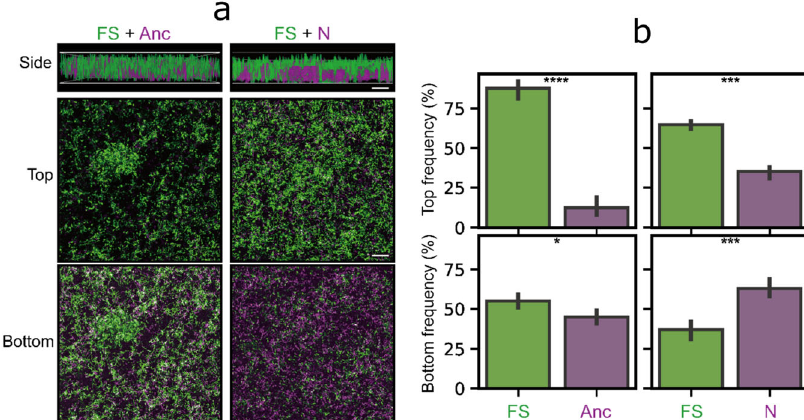
Fig. 4 Bio fi lm architectures of the competitive experiments between the FS morphotype and the other two variants. a Images represent the aerial view of mixed bio fi lms of the GFP-labeled FS morphotype and the mKate-labeled N variant or ancestor. Scale bars indicate 50 µm. The image is representative of three biological replicates. b Frequencies of each strain in the bead bio fi lms analyzed by ImageJ. The bars and the errors represent the mean ( n = 3) and the standard error of the mean, respectively. Asterisks indicate signi fi cant differences (* p < 0.05, *** p < 0.001, **** p < 0.0001; two tailed t -test with Welch ’ s corrections).